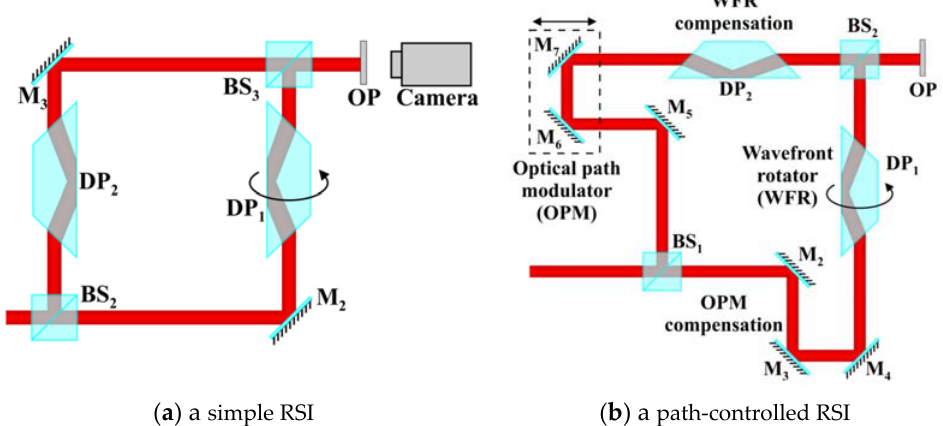
Figure 2. ( a ) An RSI implemented in a Mach–Zehnder configuration with two Dove prisms. A Dove prism DP that is rotated by an angle about the optical axis introduces the wavefront shear in the RSI. The symbols are interpreted as follows: M, mirror; BS, beam splitter; and OP, observation plane. ( b ) Conceptual design of an RSI with an electro ‐ opto ‐ mechanical delay module in one arm and a compensation module in the other arm. A computer ‐ controlled two ‐ mirror assembly in each arm is used to precisely adjust the paths in both interferometer arms for increased wavefront coherence.